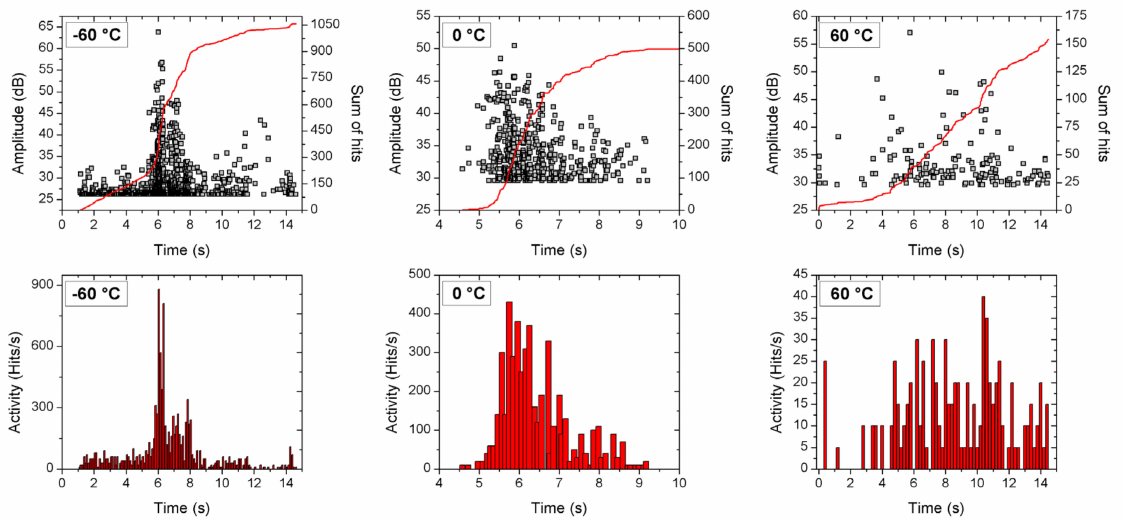
Figure 6. Acoustic activities as a function of time (the strain is proportional to the time) at different deformation